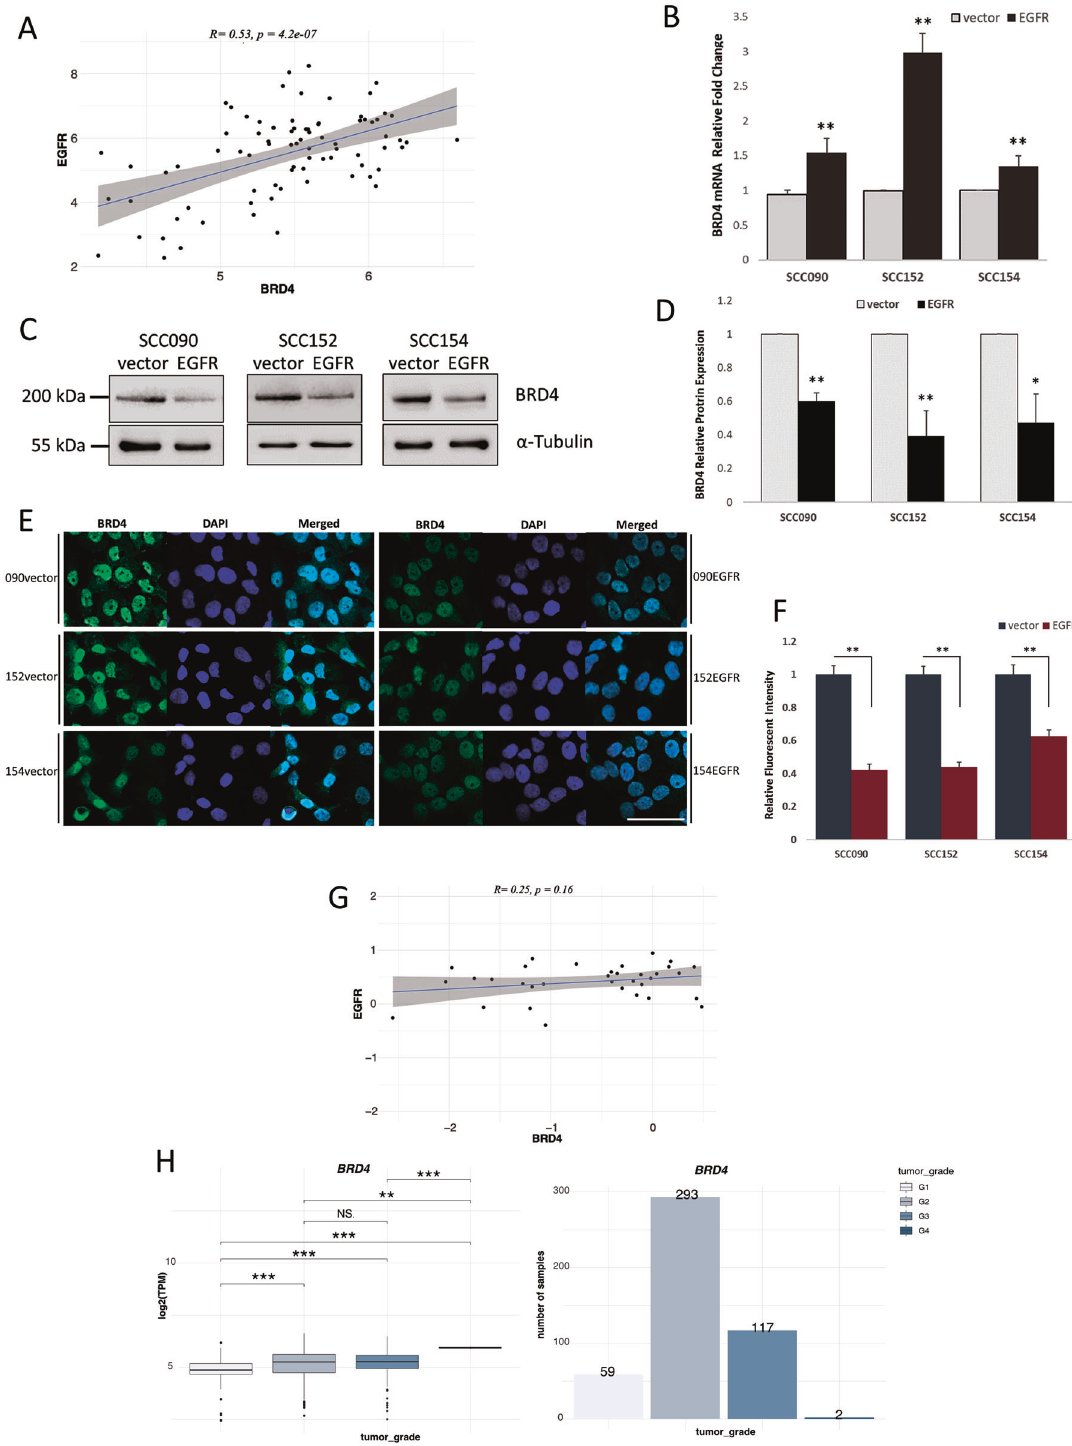
Fig. 2 EGFR overexpression is associated with BRD4 in HPV-positive HNSCC cells. A Estimated Pearson correlation factor (R) at mRNA levels for BRD4 vs EGFR in HPV-positive HNSCC samples from the TCGA database. B BRD4 mRNA expression in SCC090, SCC152 and SCC154 cells and their EGFR-overexpressing counterparts as determined by qRT-PCR of three independent RNA extractions. Statistical analysis was performed by independent t test comparing each pair of the cells (vector vs EGFR) (** p < 0.01). C Protein expression of BRD4 determined by immunoblot and their quanti fi cation of three independent measurements of BRD4 expression presented in bar-chart ( D ), independent t test (* p < 0.05, ** p < 0.01). E Fluorescence microscopy of BRD4 in HPV-positive cell line and their EGFR-overexpressing counterparts, scale bar – 50 µm and quanti fi cation of the fl uorescence intensity ( F ), independent t test (** p < 0.01). G Estimated Pearson correlation factor (R) at protein levels for BRD4 vs EGFR in HPV-positive samples from the TCGA database (TCGA RPPA). H BRD4 expression in different HNSCC tumour grades from the TCGA database, one-way ANOVA (** p < 0.01, *** p < 0.001, NS not signi fi cant) and abundances of samples for each category. Median and 25% and 75% quartiles are shown as box, 5% and 95% are visualised as whiskers. TPM values are log2 transformed.